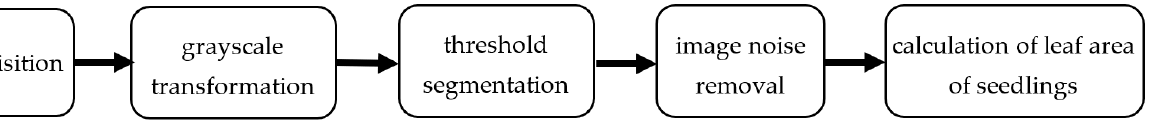
Figure 3. Flowchart for image